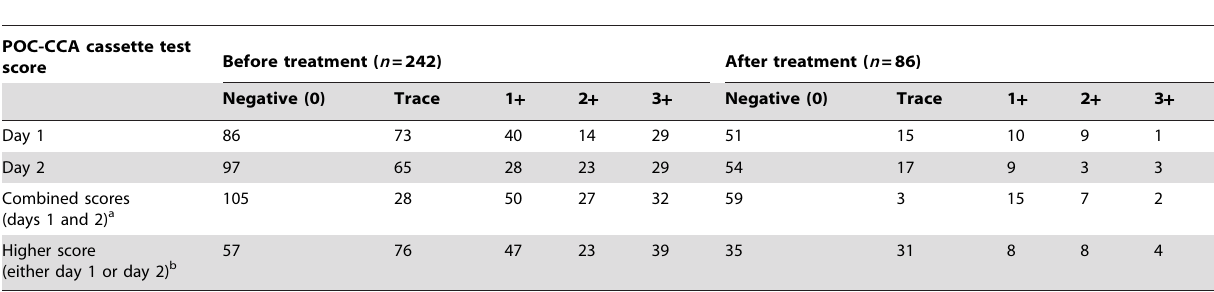
Table 5. Number of preschool-aged children falling in each POC-CCA test score before and after